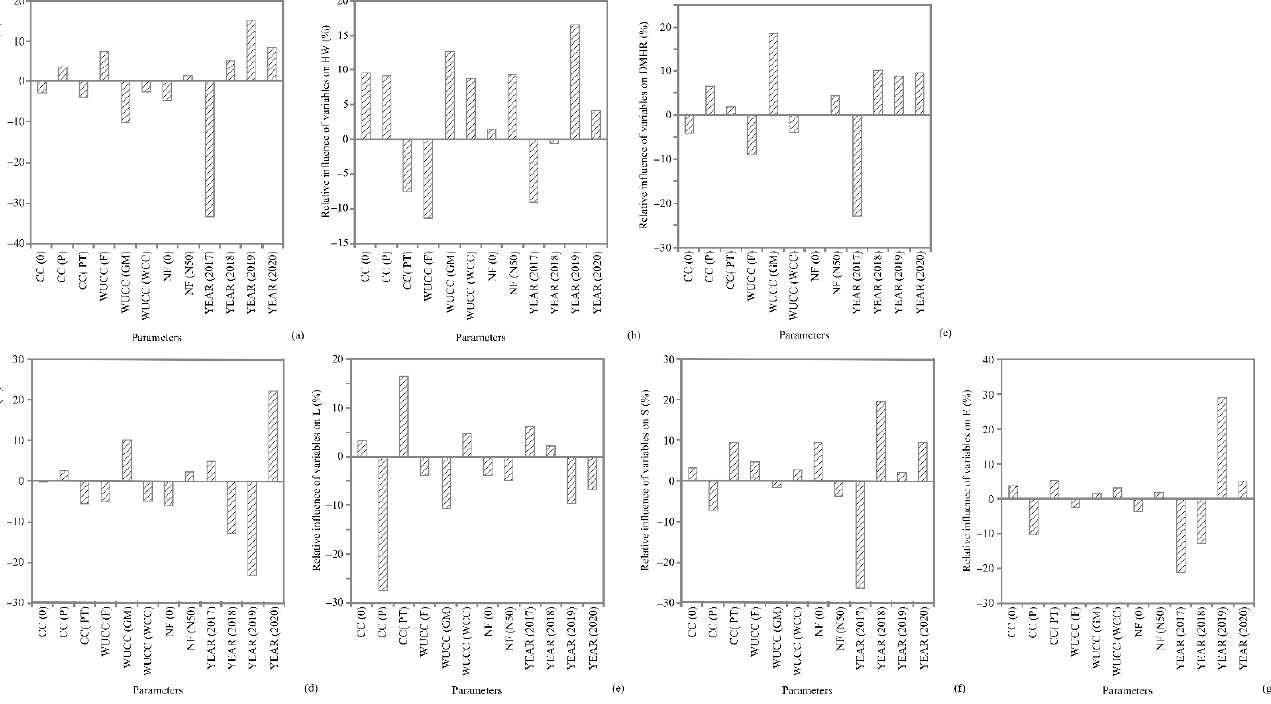
Figure 7. The relative influence (%) of CC, WUCC, NF, and YEAR on ( a ) TGW, ( b ) HW, ( c ) DMHR, ( d ) HI, ( e ) L, ( f ) S, and ( g ) E, determined using Yoon’s interpretation method.